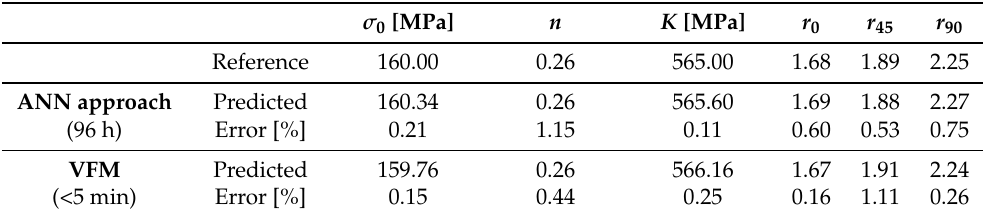
Table 5. Comparison of the ANN approach with other approaches presented in [63] for the parameter identification using the biaxial cruciform test for the test case 2.